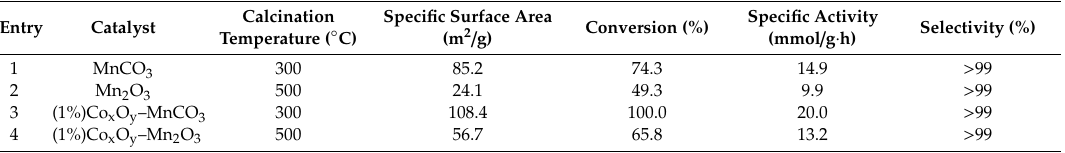
Figure 4. TGA curve of catalyst calcined at 300 °C and 500 °C i.e., (1%)Co x O y –MnCO 3 and (1%)Co x O y – Mn 2 O 3 , respectively. Table 1. Calcination temperature